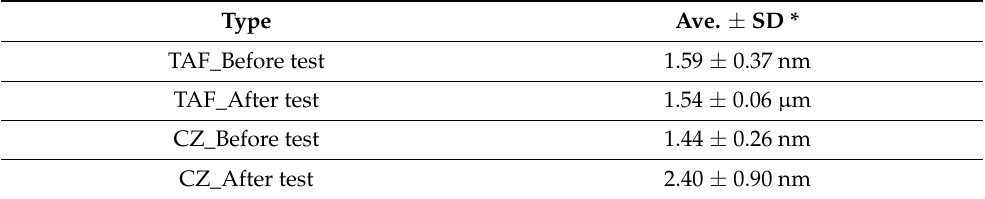
Figure 5. ( a , b ) Pictures of the TAF sample and the CZ sample before and after the external impact test; ( c , d ) variation in surface roughness ( R a ) values of the TAF sample and the CZ sample before and after the external impact test. The inset pictures in ( c , d ) were obtained through a surface analysis system. Table 3. The mean and standard deviation of surface roughness ( R a ) value of the TAF glass and the CZ sample before and after the external impact test.